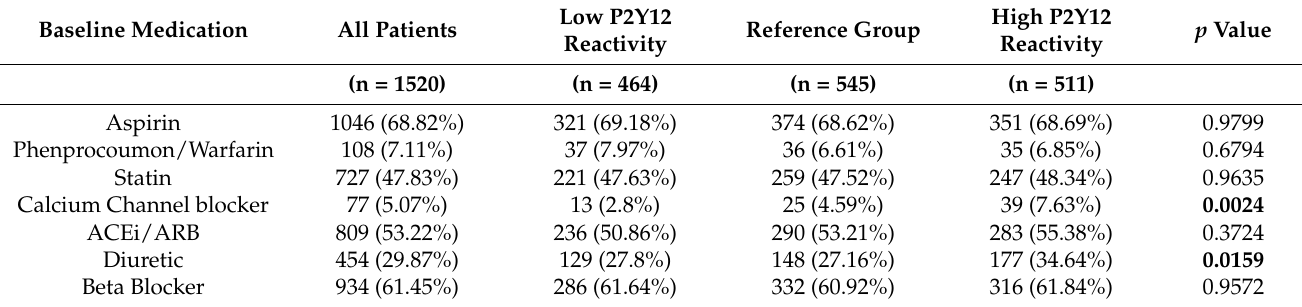
Table 2. Baseline medication stratified by platelet